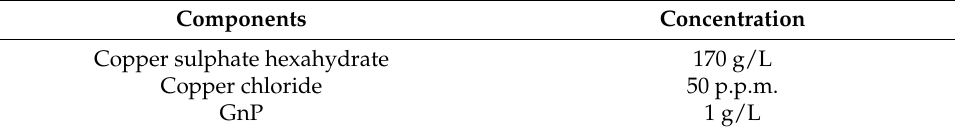
Table 4. Galvanic bath for copper-graphene